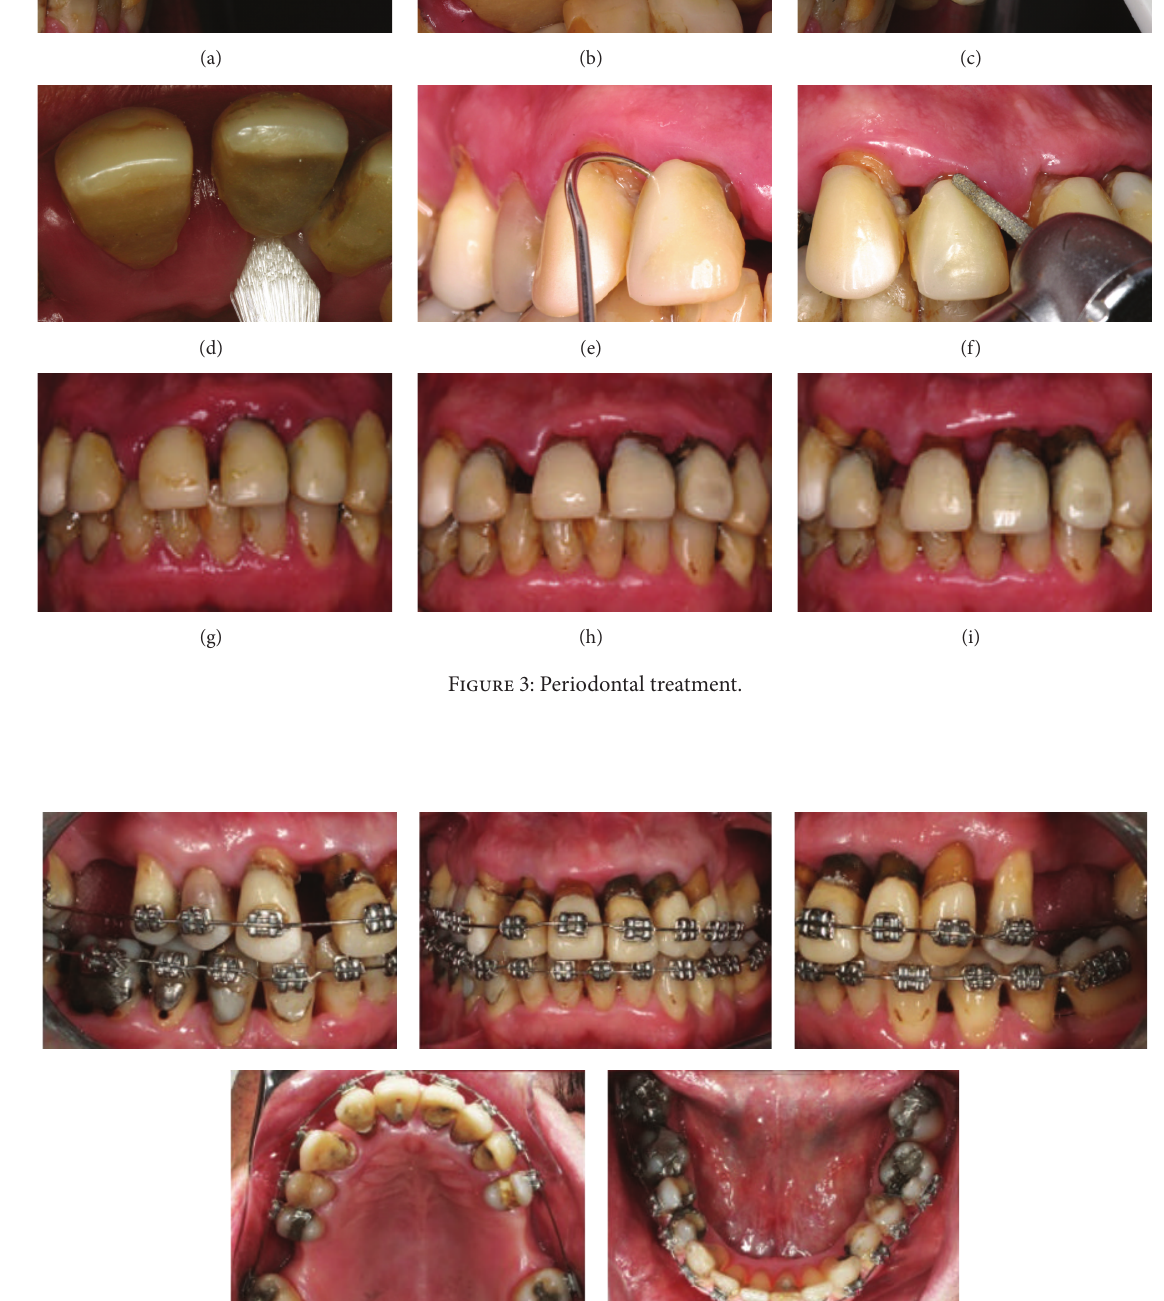
Figure 4: Treatment